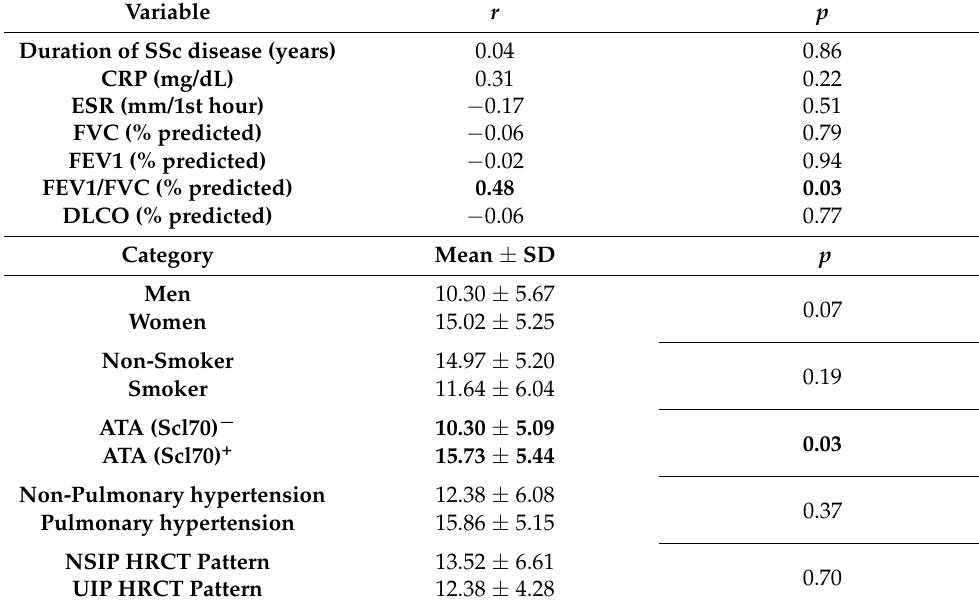
Table 3. Relationship of TAng frequency with characteristics of SSc-ILD + patients. Variable Duration of SSc disease (years)